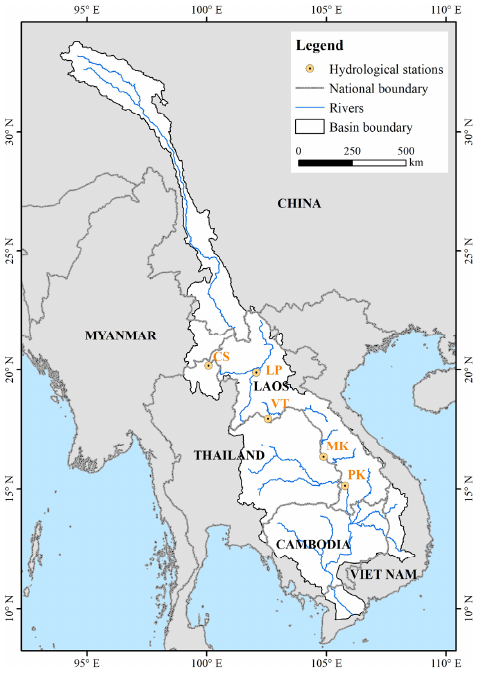
Figure 1. The LMRB and locations of the mainstream hydrological